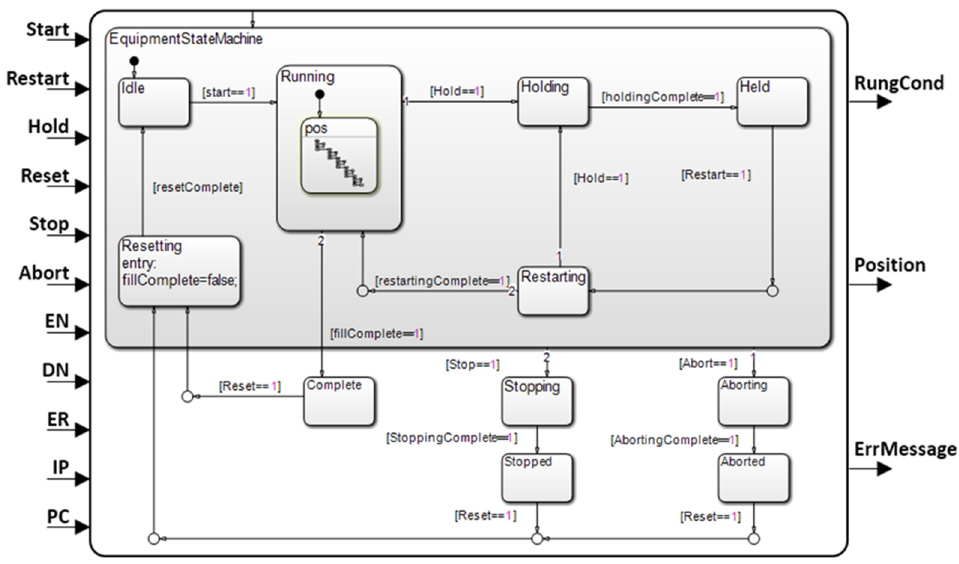
Figure 8. State machine model for custom code.